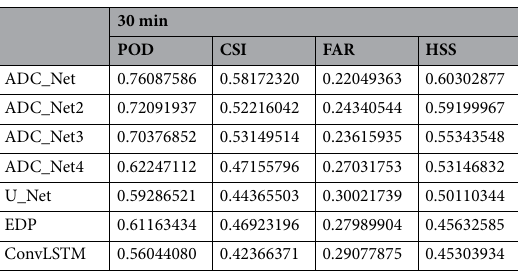
Table 1. 30-min radar echo extrapolation evaluation scores.